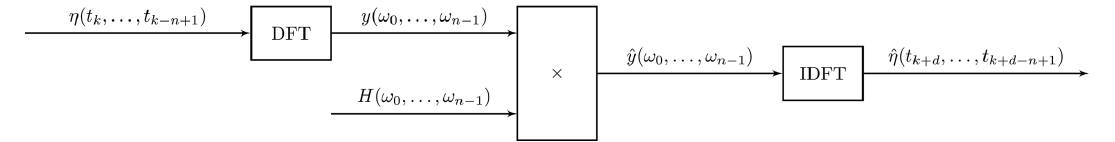
Figure 9. Scheme of the wave prediction algorithm. η is the wave elevation measurement upstream of the floating wind turbine, and ˆ η is the wave elevation at platform location; d is t d /T s time samples ahead in time.